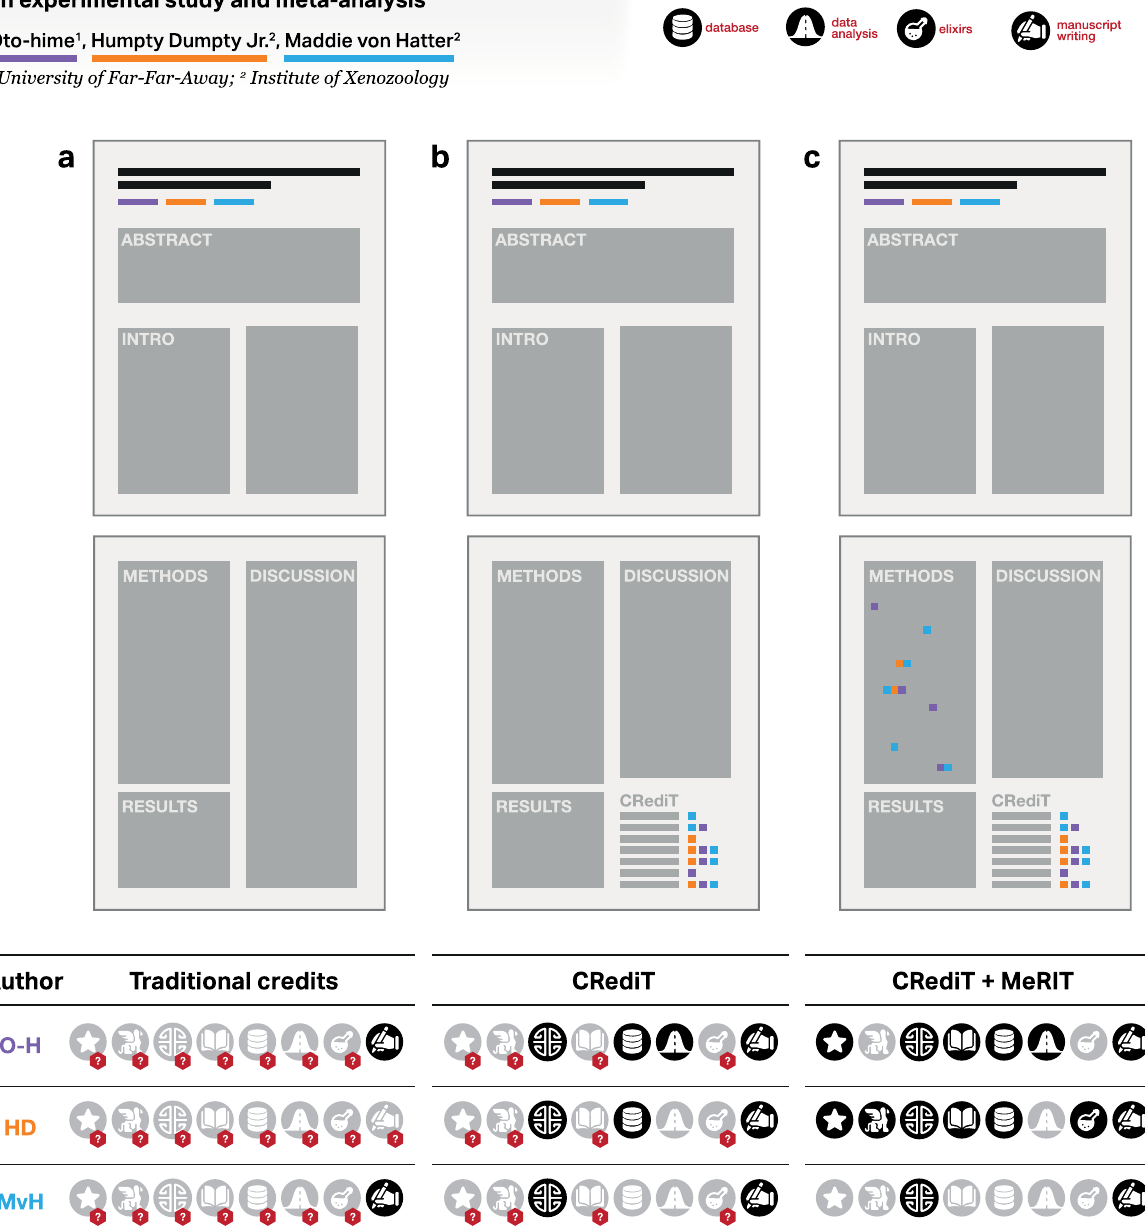
Fig. 1 | MeRIT visualized. A diagram illustrating how a combination of CRediT (Contributor Roles Taxonomy) and MeRIT (Method Reporting with Initials for Transparency) can make author contributions clearer and more granular than CRediT alone: a without CRediT and MeRIT, one can only assume the fi rst and/or